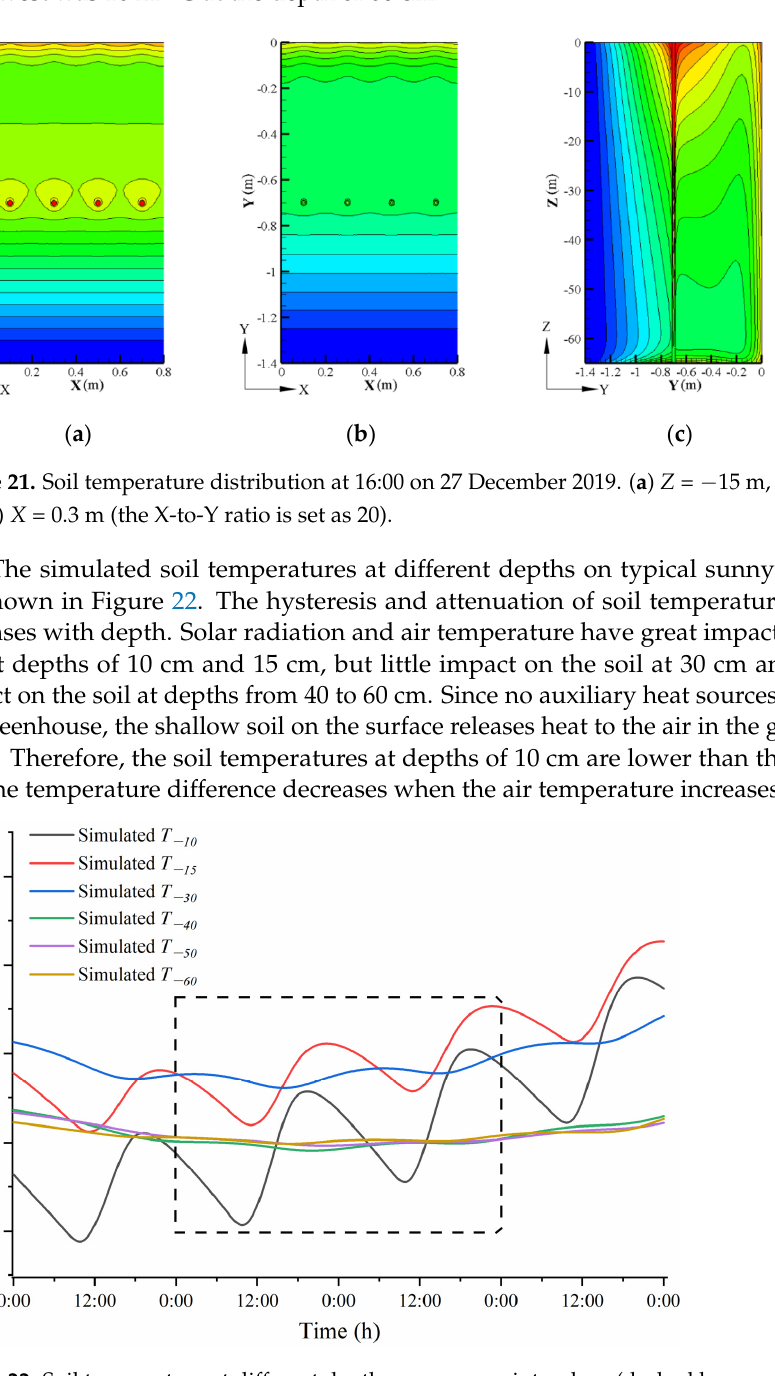
Figure 22. Soil temperature at different depths on sunny winter days (dashed box represents the soil temperatures on cloudy days, Z = − 30m).